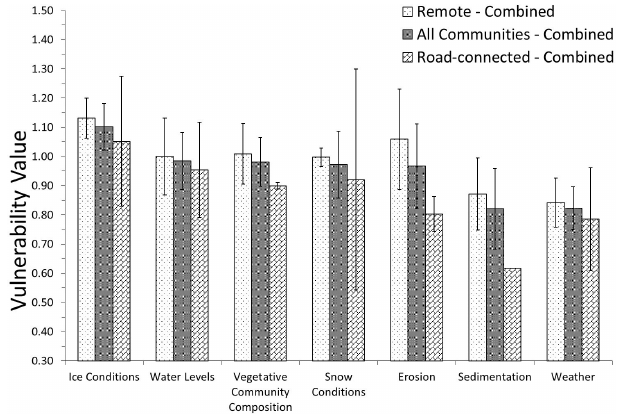
Fig. 4 . Graph comparing vulnerability values and associated margins of error for environmental conditions from GPS and interview data among remote communities, road-connected communities, and all communities